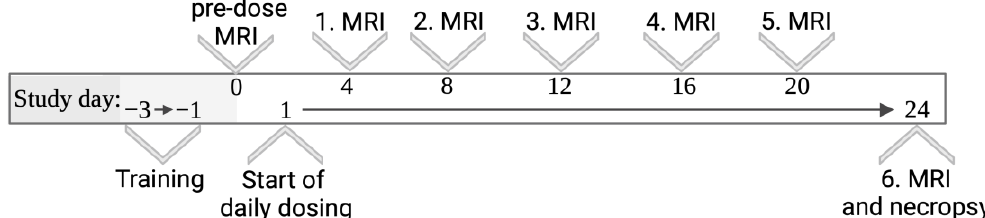
Figure 1. Study design — dose finding study.